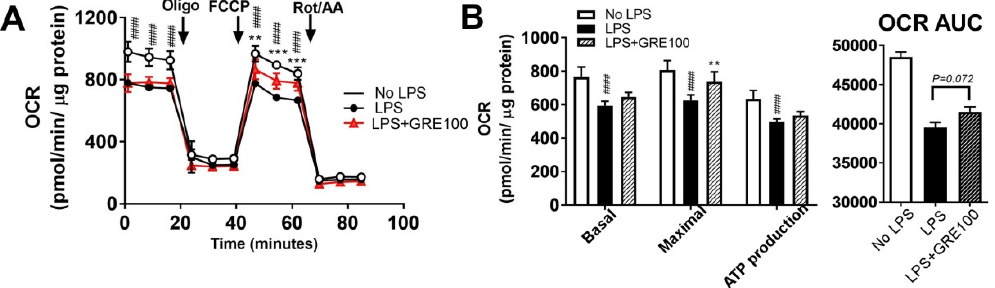
Figure 4. GR extract protected from LPS-mediated impairment of energy metabolism. RAW264.7 cells were pretreated with GRE (100 µ g / mL) for 48 h in FBS-containing completed media and then starved in DMEM for 12–18 h, followed by LPS stimulation (1 µ g / mL) for 2–4 h in the presence or absence of GRE. ( A , B ) Oxygen consumption rate (OCR) in RAW264.7 cells treated with vehicle without LPS (white circle, white bar), vehicle with LPS (black circle, black bar), and LPS + GRE (grey triangle, grey bar), as determined by Seahorse extracellular analyzer. Arrow indicates the treatment of inhibitors of oligomycin (Oligo), carbonyl cyanide 4-trifluoromethoxy phenylhydrazone (FCCP), and a combination of antimycin A and rotenone (Rot / AA). All values are presented as the mean ± SEM ( n = 5 / group for each experiment). #### p < 0.0001; compared with non-LPS-treated group vs. LPS-treated group. ** p < 0.01; *** p < 0.001; compared with LPS-treated group vs. LPS + GRE-treated group by one-way ANOVA or two-way ANOVA with Bonferroni’s comparison test.